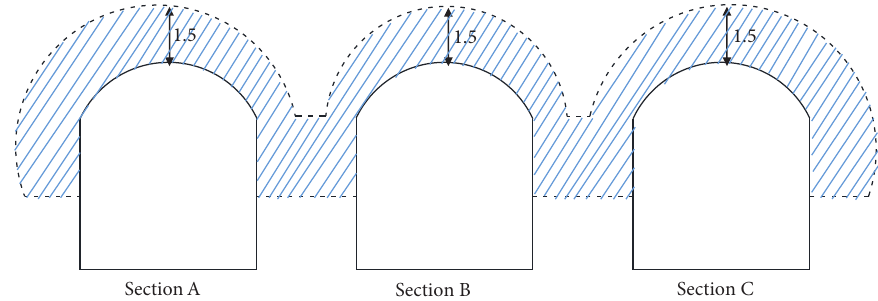
Figure 10: Reinforced section